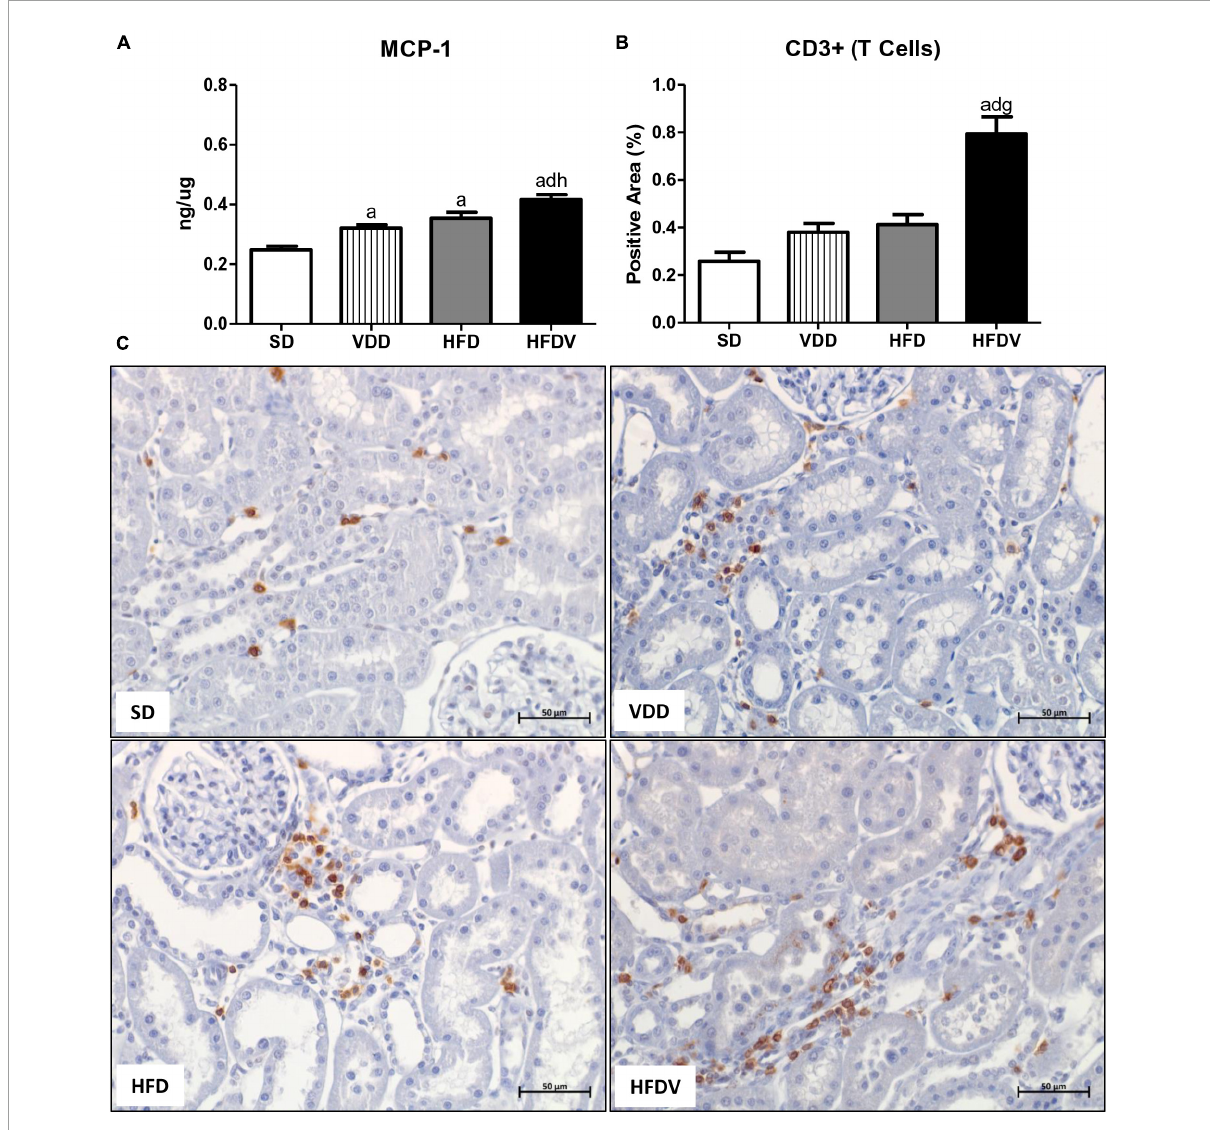
FIGURE5 Quantitative amount of monocyte chemotactic protein 1 (MCP-1)—ELISA and immunohistochemical analysis for CD3+ cells (T cells) expression in renal tissue evaluated after the 90-day protocol in rats submitted to renal ischemia-reperfusion insult on day 45 treated with standard diet (SD), vitamin D-free diet (VDD), high-fat diet (HFD), or high-fat vitamin D-free diet (HFDV). (A) Bar graphs of MCP-1 quantification and (B) CD3+ cells expression values. (C) Representative photomicrographs of immunostaining for CD3+ cells in the renal cortex from an SD, VDD, HFD, and HFDV rat ( × 400). Data are mean ± SEM. a p < 0.001 vs. SD; d p < 0.001 vs. VDD; g p < 0.001 and h p < 0.01 vs .